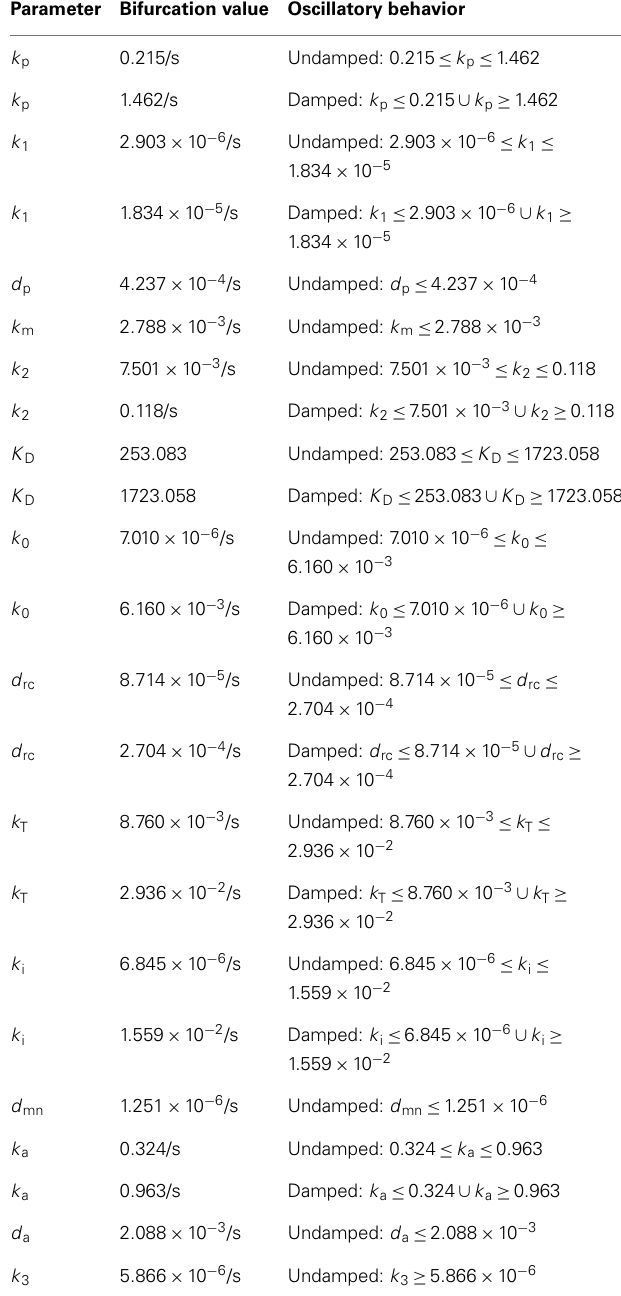
Table 3 | Bifurcation points in the deterministic